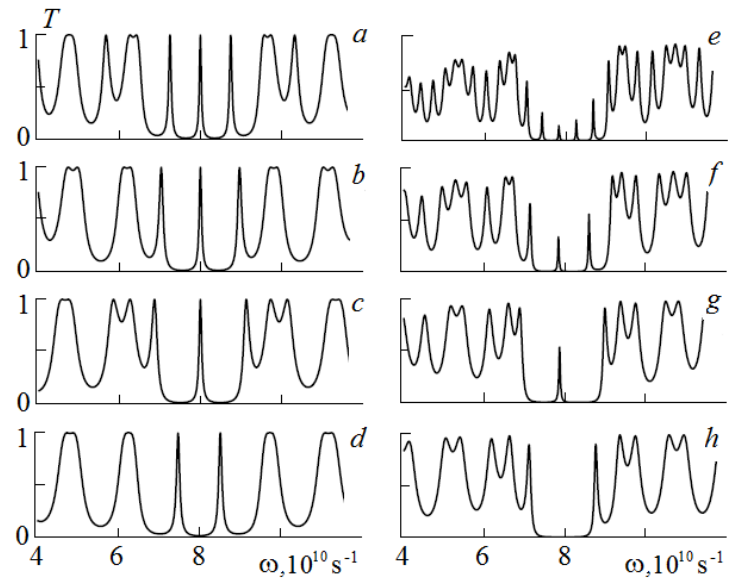
Figure 4. Transmission spectra of the MCR with the vacuum cavity ( a – d ) and the cavity filled with a finely layered ferrite-semiconductor medium ( e – h ) with the thickness L 3 = 2 λ 0 , λ 0 , λ 0 /2, λ 0 /4; λ 0 = 2.36 cm at H 0 =